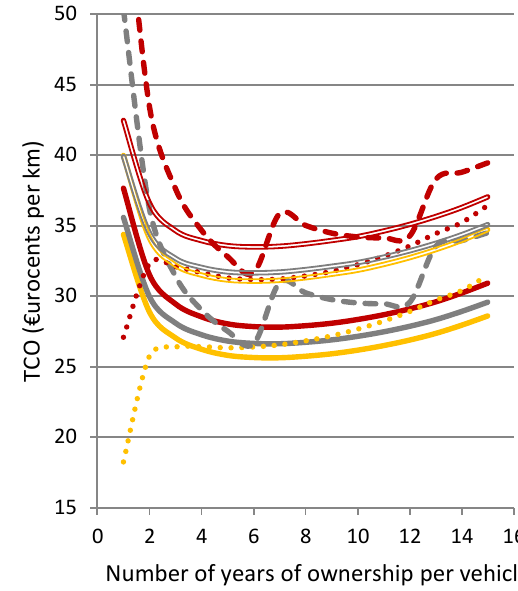
Figure 5. TCO sensitivity on the years of ownership of the quadricycles